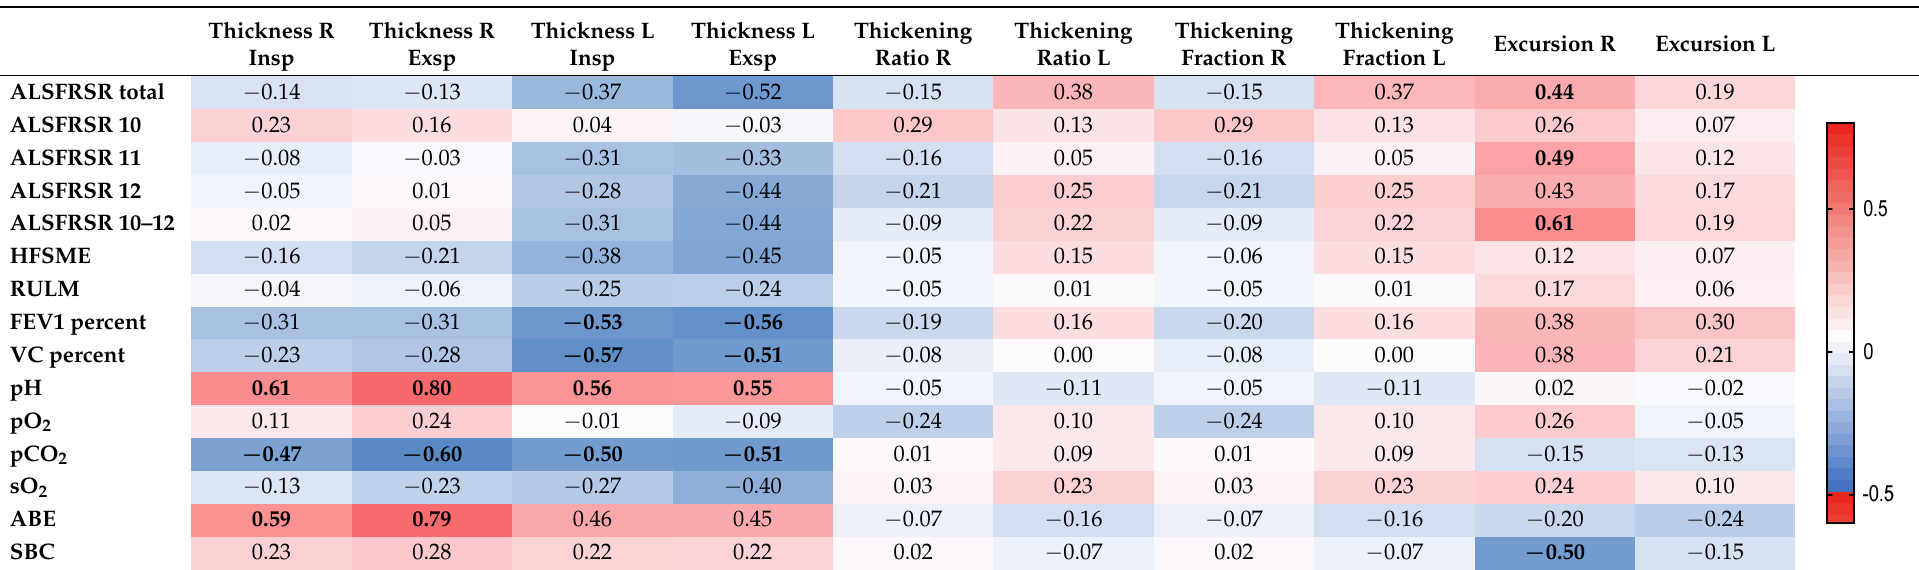
Table 4. Correlation of diaphragm B and M mode ultrasound parameters and classical measures of respiratory dysfunction in SMA